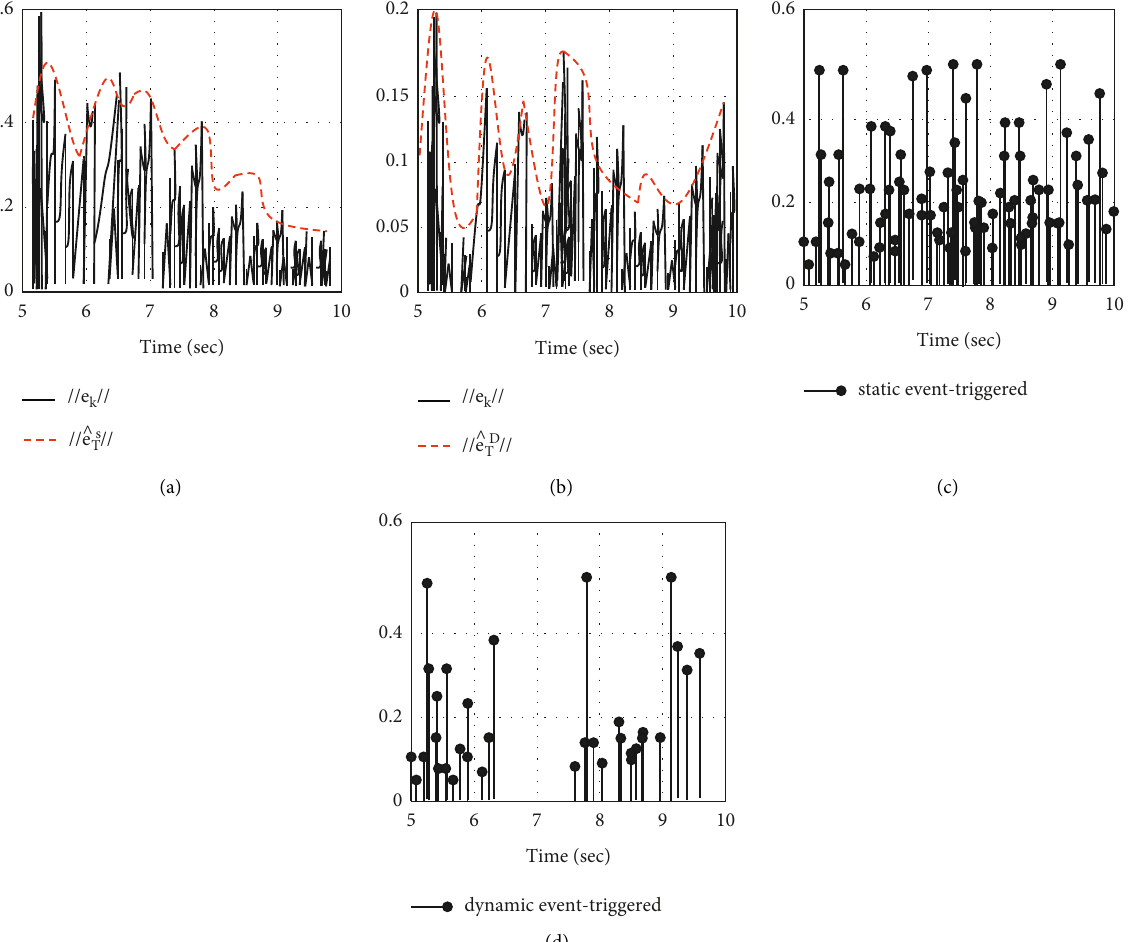
Figure 5: Comparison of static event triggering and dynamic event triggering in the learning phase. (a) and (b) are sampling error and trigger threshold, respectively; (c) and (d) are sampling time and sampling interval,